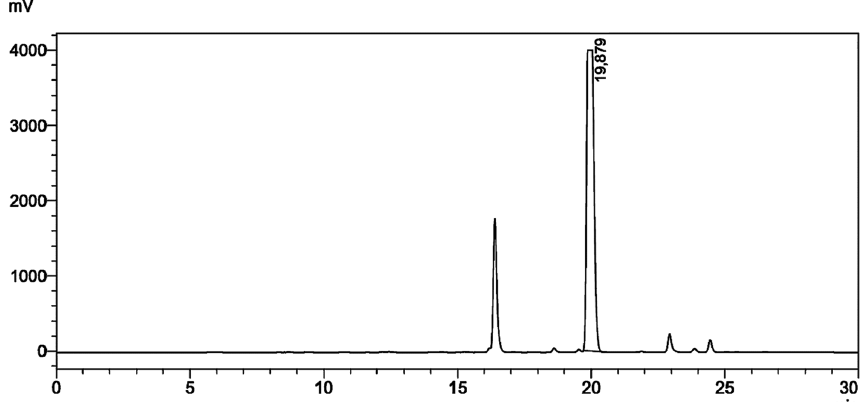
Fig. 1 Purification (UV chromatogram) of precursor 6 (Method parameters: gradient flow; 0–10 min 40% B volume: 5 mL, Precursor 6 RT: ~ 20